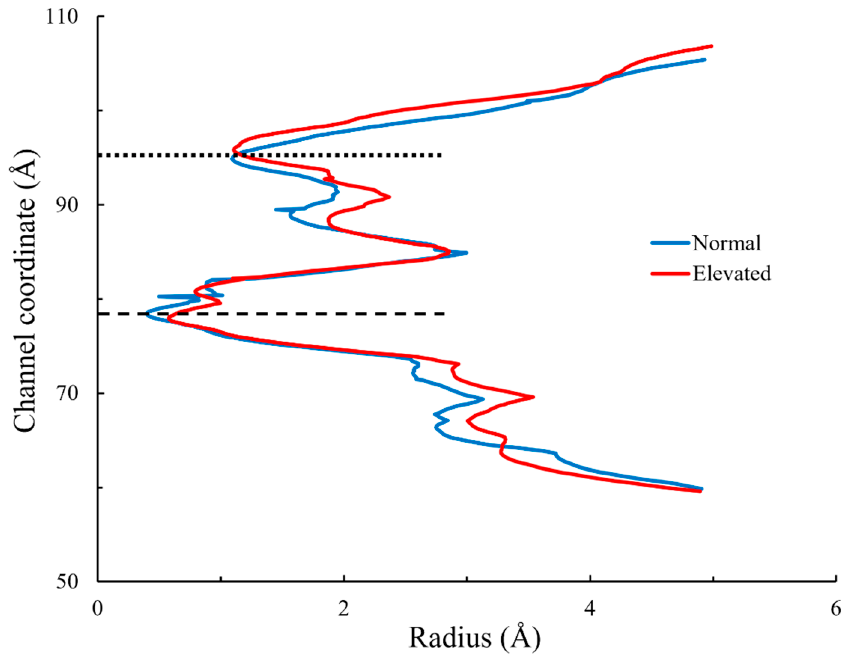
Figure 5. Pore-channel radius at 100 ns timeframe. Pore-channel radii at normal and elevated hydrostatic pressures are shown in blue and red, respectively. The dashed and dotted lines indicate the position of the TRPV1 lower and upper gates, respectively.